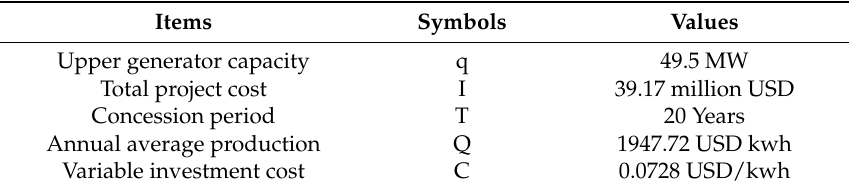
Table 1. Summary of input parameters in the case study.